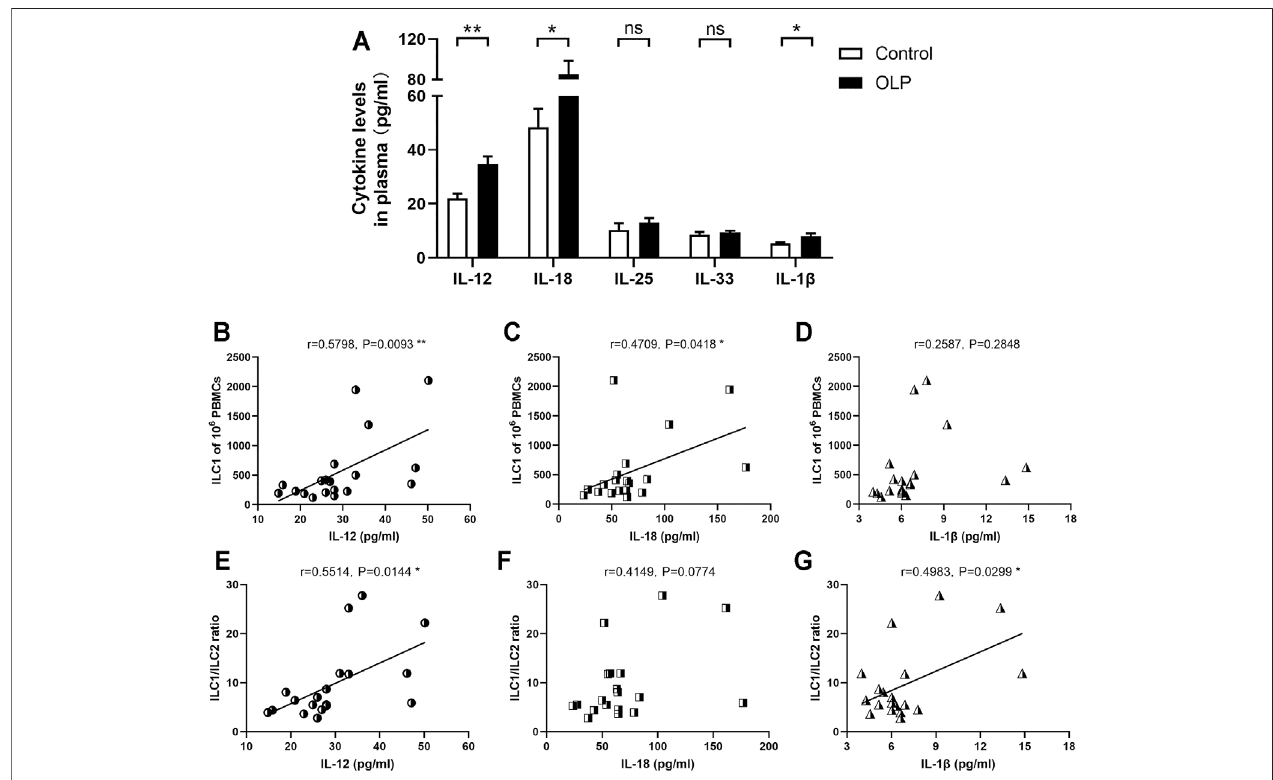
FIGURE 5 | Plasma levels of ILC-related activation factors. Plasma extracted from OLP patients and healthy controls was measured by ELISA kits. (A) The expression levels ofIL-12, IL-18, IL-25, IL-33, and IL-1 β .Correlationofthe expression levels ofIL-12, IL-18, and IL-1 β with corresponding circulatingILC1 counts (B – D) or ILC1/ILC2 ratio (E – G) . Data are depicted in correlation plots or as a bar graph with mean ± SEM. Two-tailed unpaired Mann – Whitney tests and Spearman ’ s rank correlation tests were performed, * p < 0.05, ** p < 0.01. ILC, innate lymphoid cell; OLP, oral lichen planus.